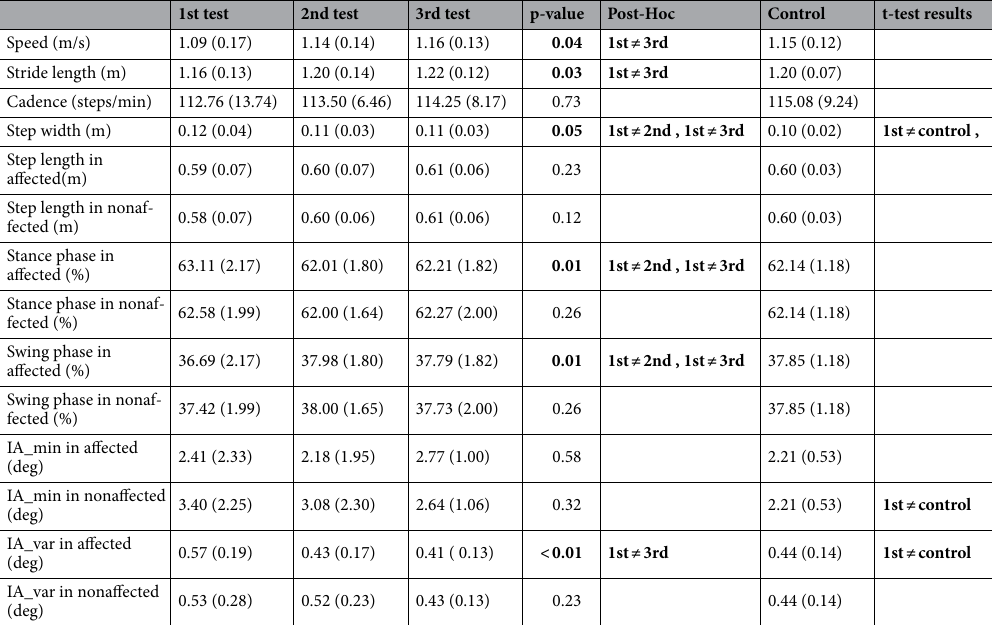
Table 4. Changes in gait metrics during repeated tests for uVN and comparison between uVN and control. 1st test were conducted within 2 weeks of Department of Otorhinolaryngology-Head and Neck Surgery. 2nd test and 3rd test were conducted after 4 weeks and 8 weeks of 1st test. p-values are from the statistical test for the time effect on gait metrics. T-test results describe significantly different groups between control and uVN at each time. T-test was conducted for control and each time, respectively. Values are mean (SD). uVN unilateral vestibular neuritis, IA inclination angle in frontal plane, var variability, SS single stance phase, min